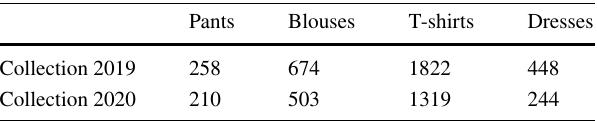
Table 1 Number of items for each family of products in 2019 and